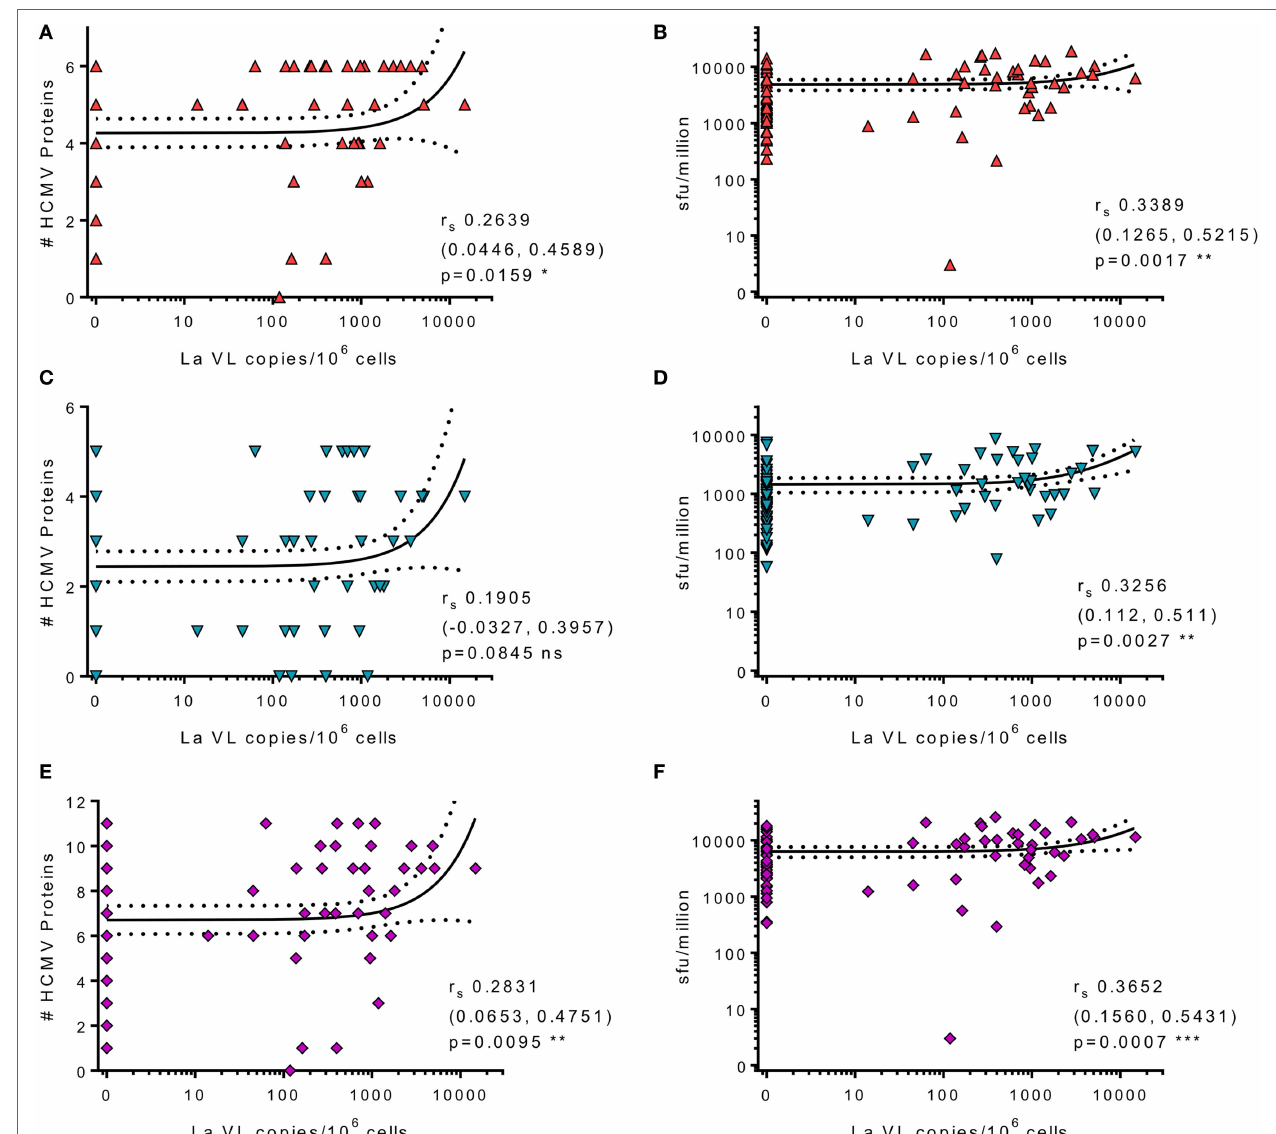
FigUre 8 | High levels of latent human cytomegalovirus (HCMV) load in CD14 + monocytes correlates with increased frequency and breadth of HCMV-specific IFN γ CD8 + T cell responses. The HCMV viral load (copies/10 6 CD14 + cells) from 83 HCMV seropositive donors was correlated with CD8 + HCMV-specific T cell responses. Graphs illustrating the breadth (positive response) of individual donors CD8 + IFN γ response to the 6 lytic expressed (red) (a) , 5 latency-associated (blue) (c) , and all 11 HCMV proteins (purple) (e) correlated with CD14 + cells HCMV viral load are shown. The magnitude of the CD8 + IFN γ response summed for all protein groups is correlated with HCMV viral load for lytic (red) (B) , latent (blue) (D) , and all proteins (purple) (F) . Spearman rank correlation [Spearman r s (95% confidence intervals) and p values] results are indicated on each